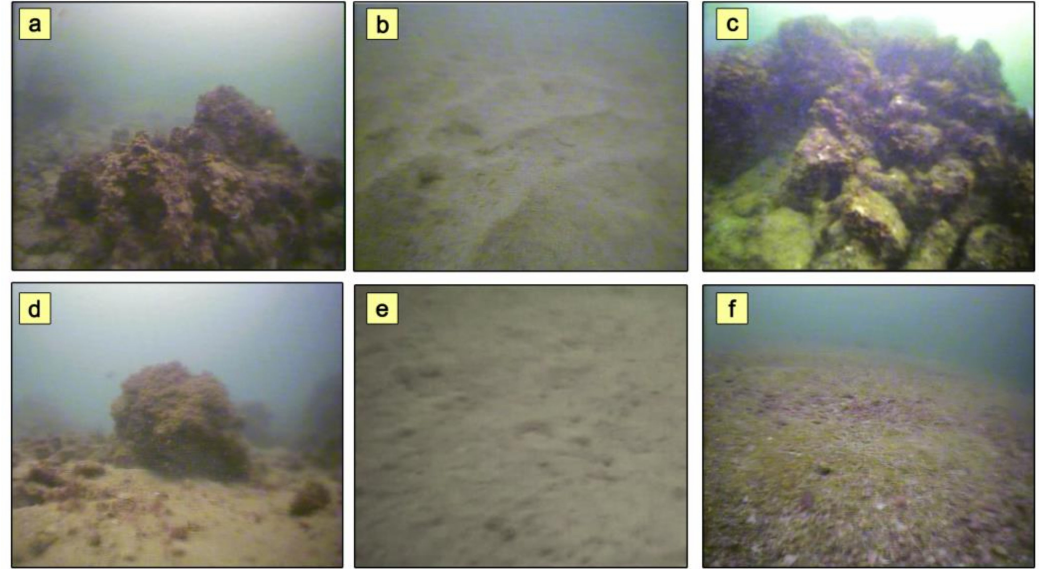
Figure 6. ( a – f ): Seafloor images obtained from the ROV camera dives around the six sampling stations (not to